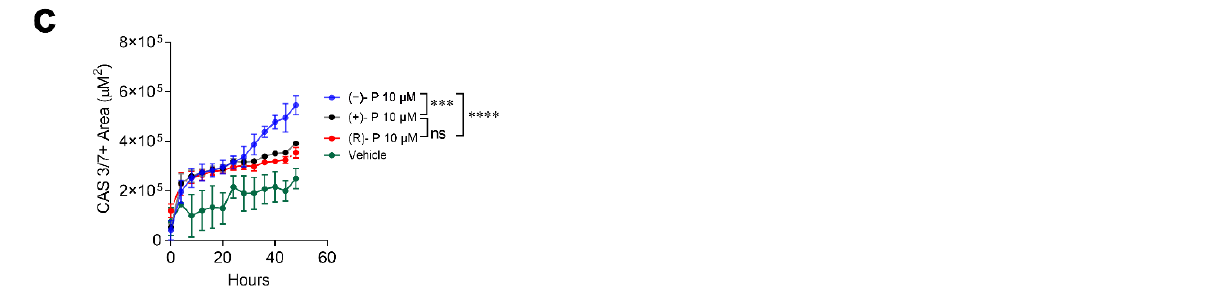
Figure 4. The kinetics of ( − )-P-, (+)-P- and (R)-P-induced caspase 3/7 activation in HT29 cells grown as spheroids. HT29 spheroids were grown for 96 h, followed by live-cell imaging for a further 96 h in the presence of ( − )-P, (+)-P and (R)-P and Caspase-3/7 Green reagent using an Incucyte S3 Live analysis system. ( a ) Representative images of HT29 spheroids 96 h post drug treatment. White bars represent 800 µ m. ( b ) Caspase 3/7 kinetics curves generated by measuring the caspase 3/7 positive area within HT29 spheroids for ( − )-P, (+)-P and (R)-P over 96 h. ( c ) Comparison of caspase 3/7 activation over 48 h after treatment with vehicle or 10 µ M ( − )-P, (+)-P and (R)-P. Individual points represent the mean ± SD from three technical replicates in a single experiment. *** p ≤ 0.001, **** p ≤ 0.0001. Two-way ANOVA with multiple comparisons test. Data are representative of two independent experiments.